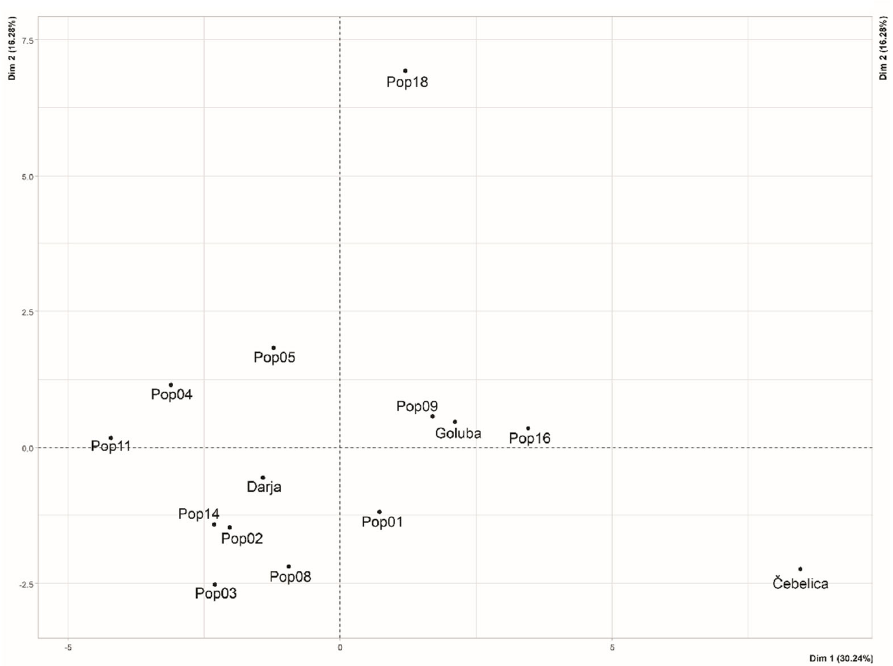
Figure 2. Factor map portraying the relationships of 14 analyzed common buckwheat accessions based on their morphological